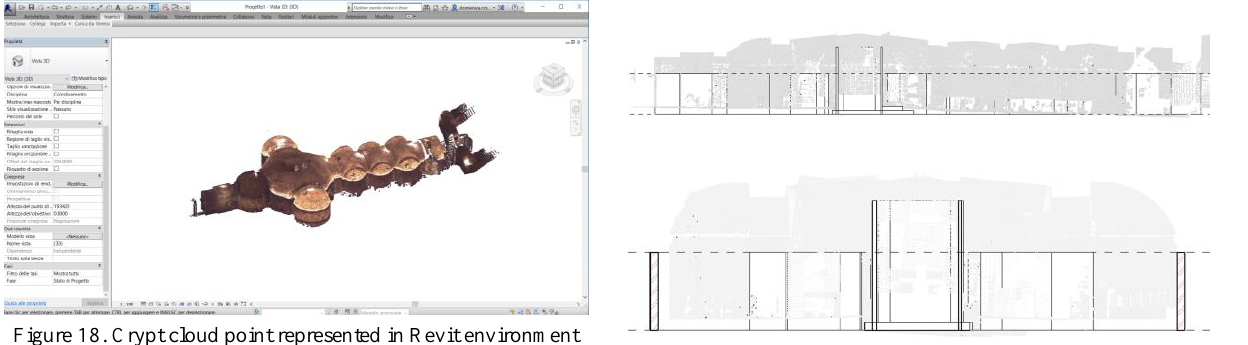
Figure 21. Longitudinal (up) and transverse (down) type section